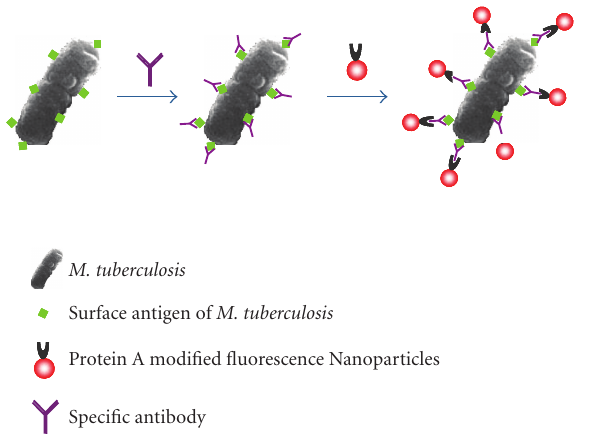
Figure 2: Schematic representation of the principle of the detection of M. tuberculosis with the fluorescent nanoparticle-based indirect immunofluorescence